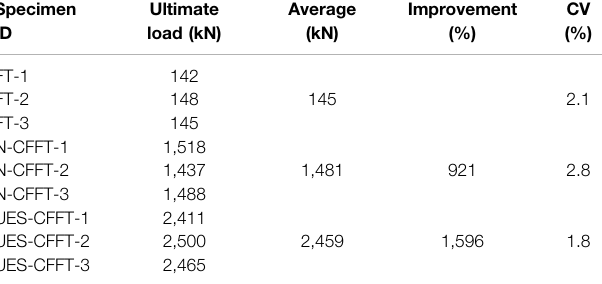
TABLE 5 | Load capacities of the three types of specimens under compression.